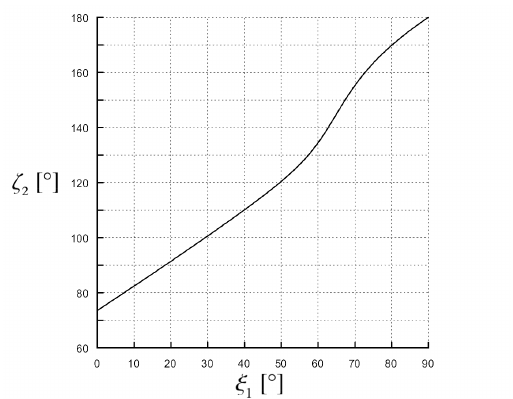
Figure 7. Transmitted angle of the attenuation vector, ζ 2 in degrees, as a function of the incident angle of the phase vector, ξ 1 in degrees. Medium 1 is a vacuum, medium 2 has ε (cid:48) The magnitude of the incident phase vector is the critical one in Equation (3) when ε (cid:48)